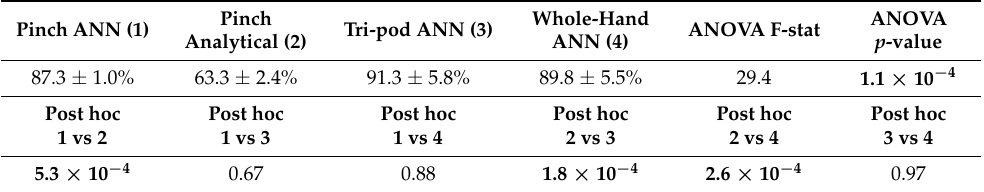
Figure 3. True positive rate detection of secure grasp depended if ANN utilized for prediction of precision pinch, tri-pod grip, or whole-hand grip versus analytical (cancellation) method utilized for precision pinch. Table 2. Mean value comparisons for prediction (true-positive rate, %) of secure